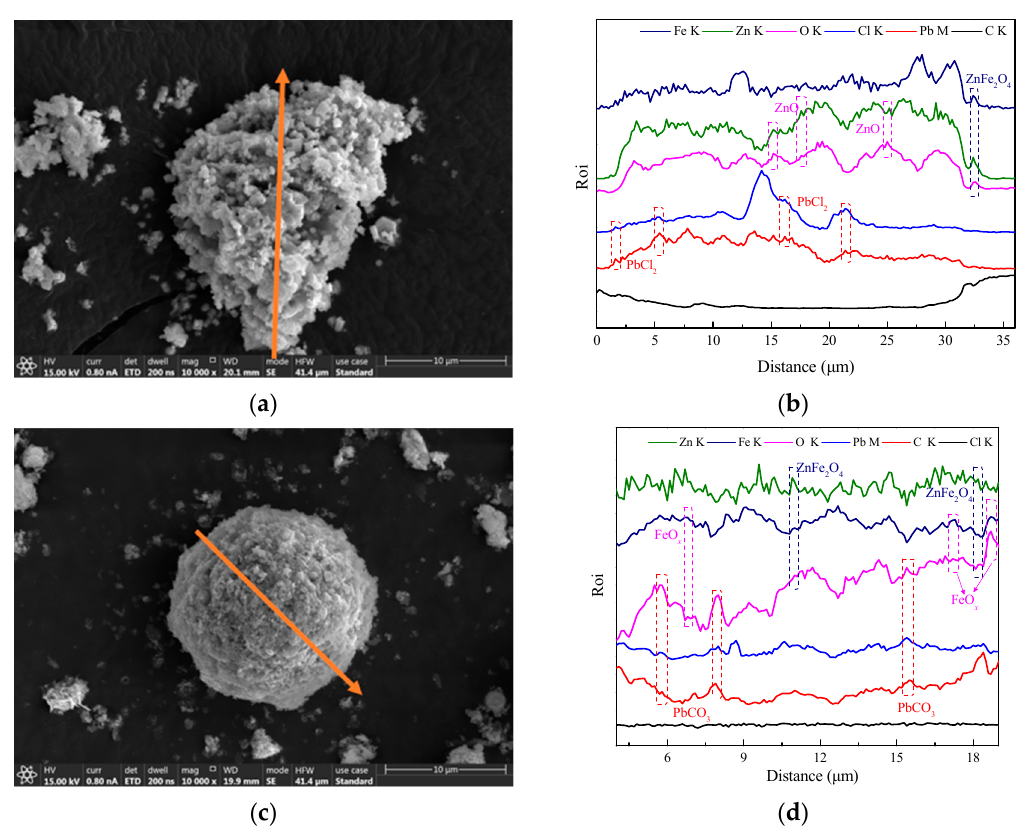
Figure 18. Line-scanning patterns of ( a , b ) SZO and ( c , d ) the leached residue.